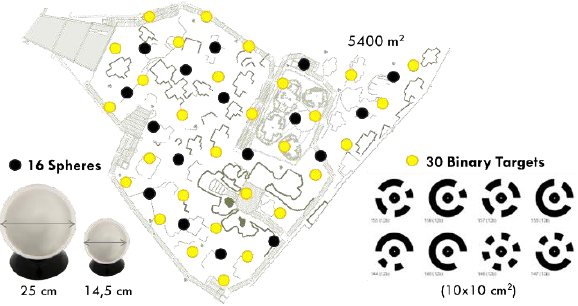
Figure 4. Reference network based on spheres and binary photogrammetric targets.